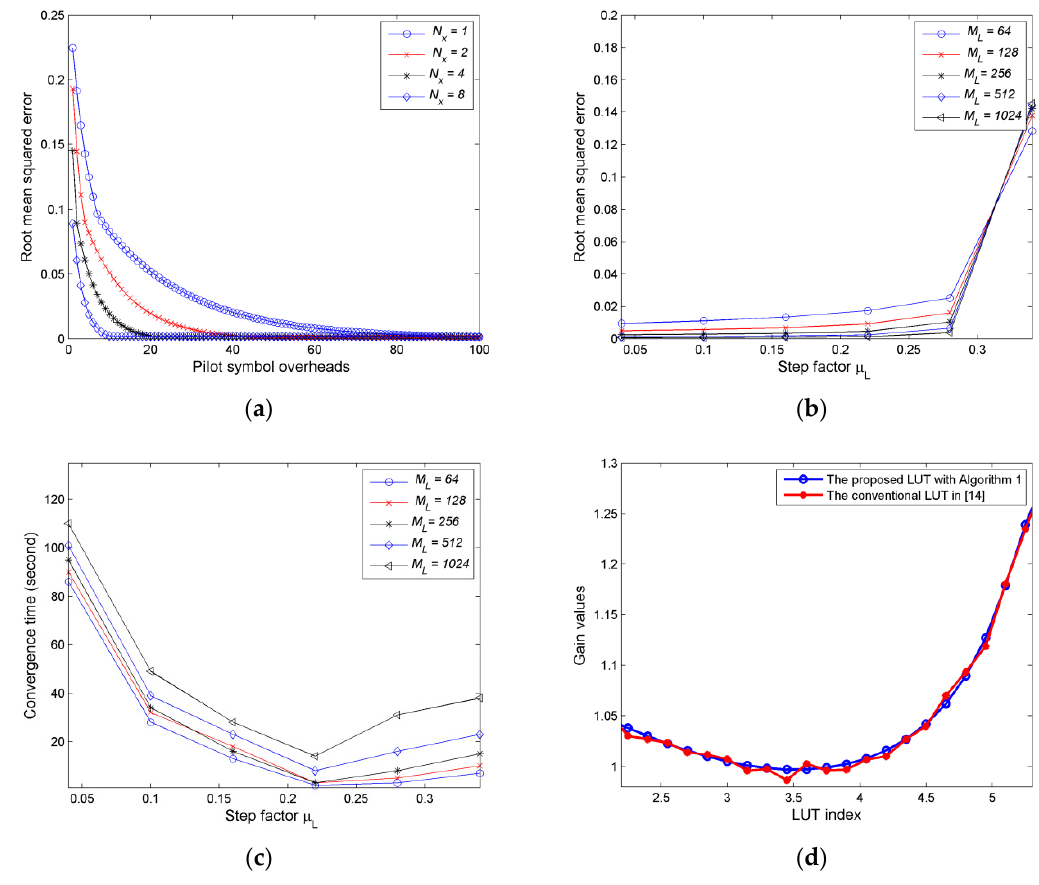
Figure 11. Algorithm training ( a ) for different split slots ( b ) for different step factors ( c ) for different LUT sizes ( d ) corresponding LUT gain value. LUT sizes ( d ) corresponding LUT gain